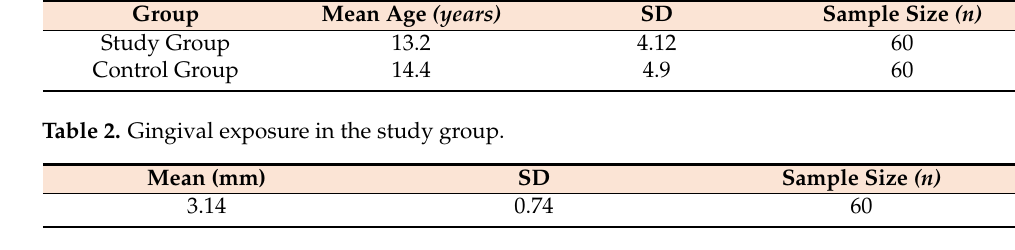
Table 1. Description of the samples in terms of age. Group